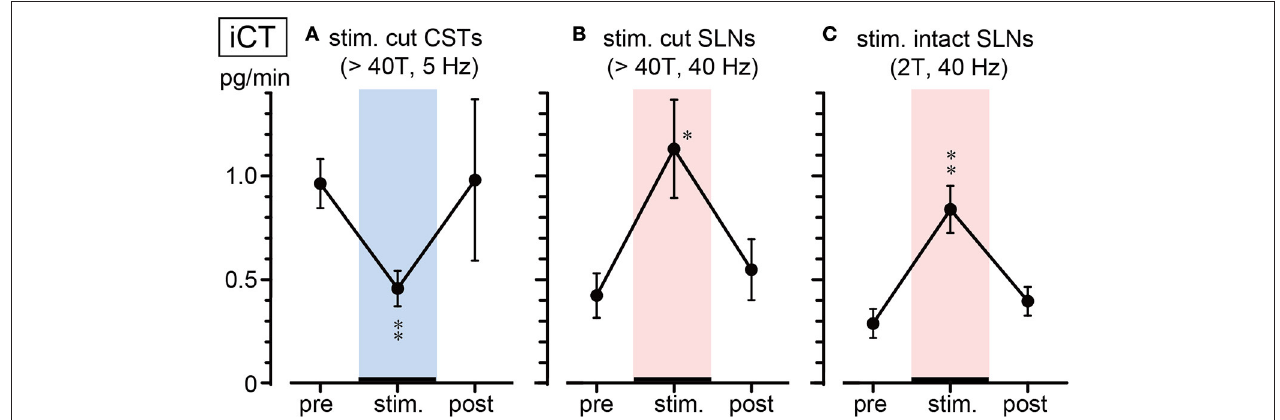
FIGURE 3 | Summary of iCT secretion rate during electrical stimulation of cut CSTs (A) , cut SLNs (B) , and intact SLNs (C) . Circles and vertical bars show the mean ± standard error. Significant differences were determined by comparison with the prestimulus values (* p < 0.05, ** p < 0.01).